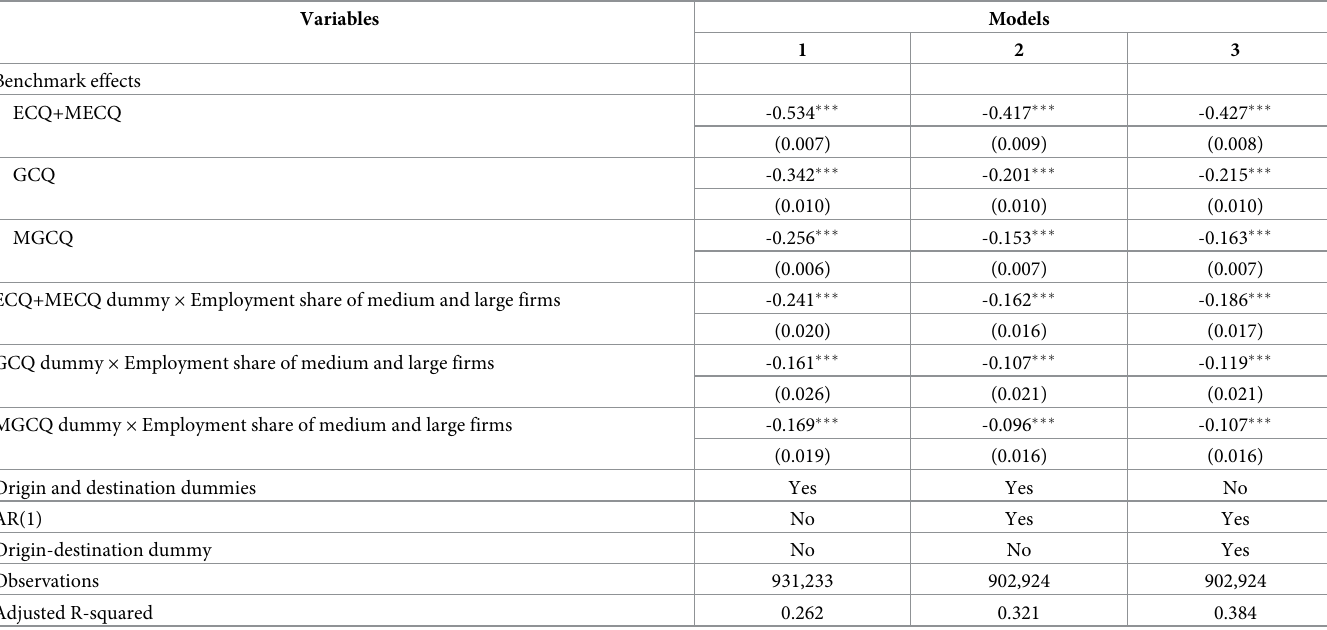
Table 2B. Effects of lockdown measures by destination city firm size composition